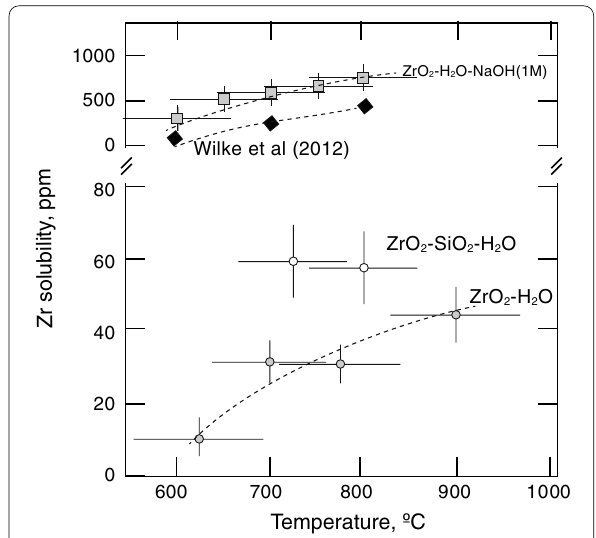
Fig. 25 Zirconium solubility in aqueous solutions as a function of temperature and pressure for the various systems indicated on individual dashed lines. Modified from Mysen